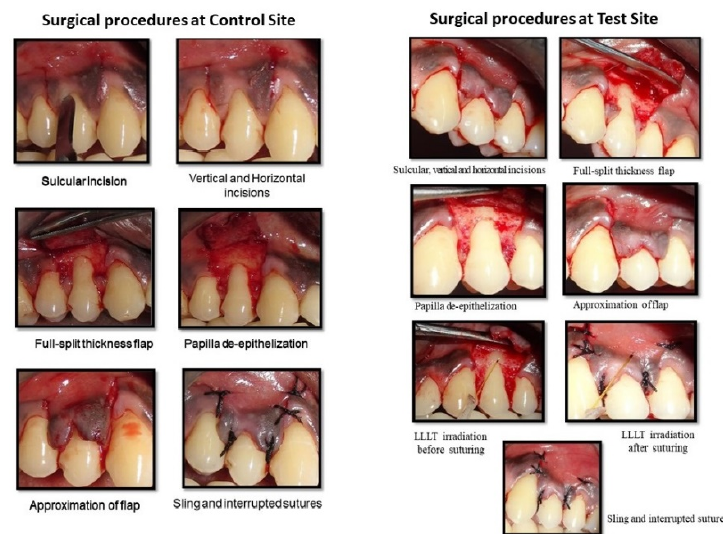
Figure 1. Surgical procedures at the control and test sites.